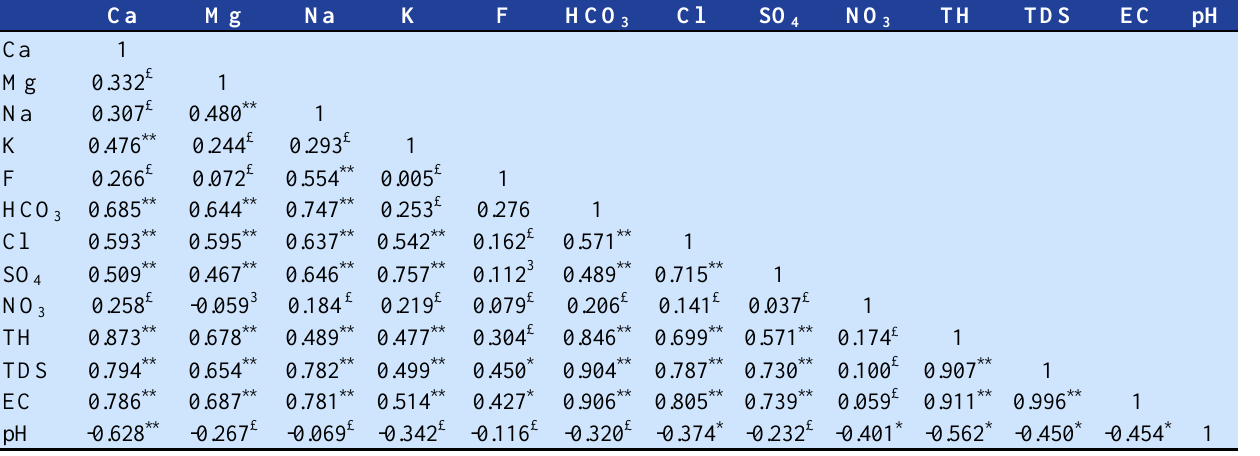
Table 3.Correlation matrix of studied water quality